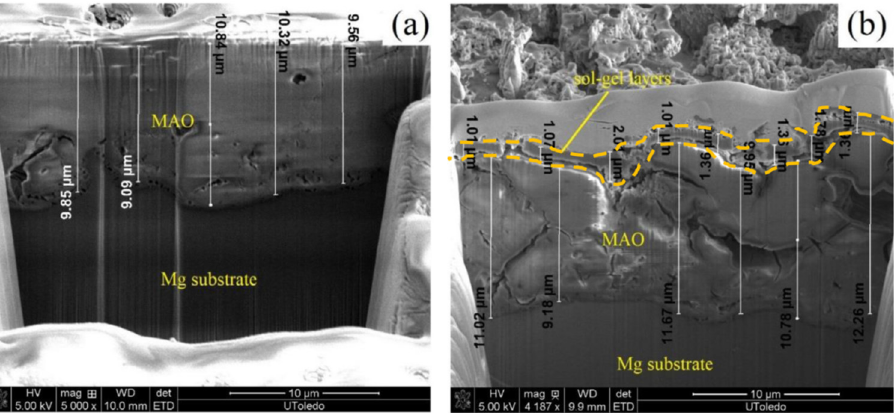
Figure 24. Adapted with permission from H. Ibrahim et al. [127]. Copyright 2019 Elsevier. License number 5318830570042. SEM cross-section images of ( a ) PEO coating and ( b ) PEO + sol-gel coating.